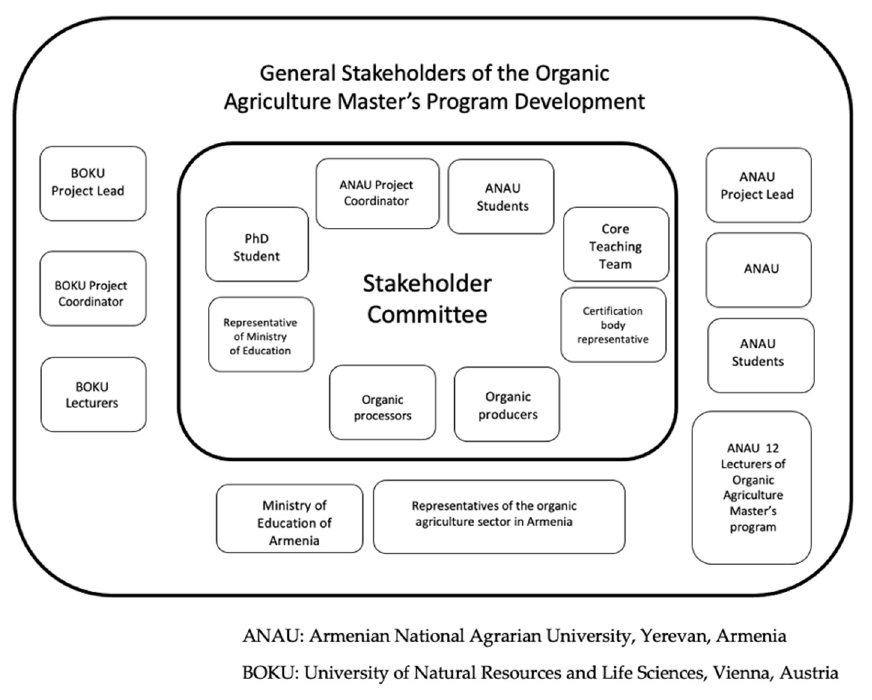
Figure 3. Stakeholder map of the Organic Agriculture Master’s program and the Stakeholder Committee.